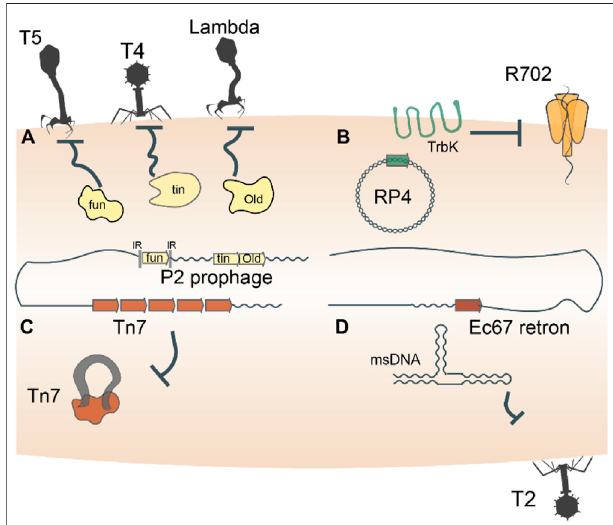
FIGURE 1 | Entire mobile genetic elements double as defense systems. Autonomous MGEs, such as bacteriophages, plasmids, transposons and retrons,encodegenesthatdefendthehostcellsagainstinvasionbyrelated or unrelated MGEs (A – D) . For example, trbK encoded by the broad host range plasmid RP4 excludes plasmid R702. Such defense-related genes are frequently shuttled back and forth between MGEs and their host cells, such as, for example, the Old family nuclease encoded by phage